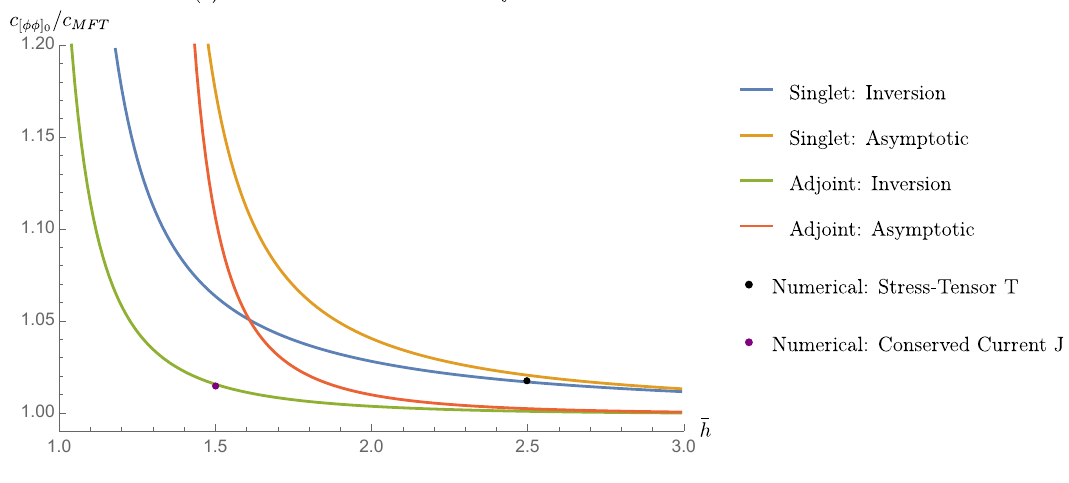
Figure 4 . OPE coefficients for f taken from [5] and the OPE coefficients are normalized by dividing by the mean field theory OPE